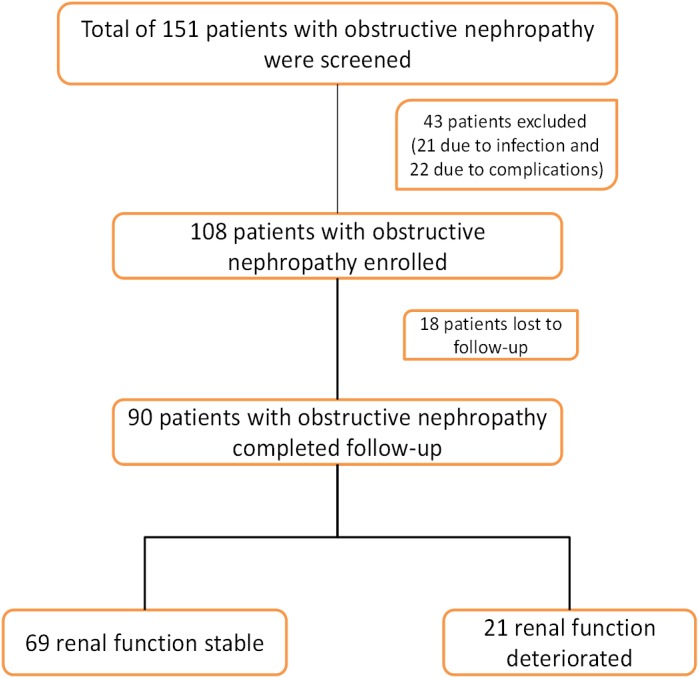
Study flow chart.